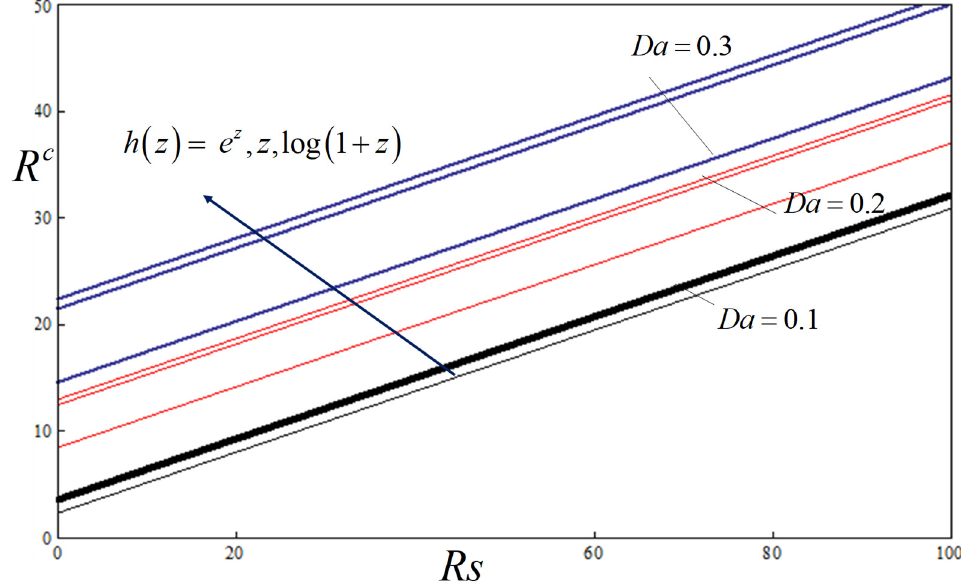
Figure 12. Plot of R c versus Rs for three cases of negative gravity fluctuation for various values of Da with Le = 0.5, Rs = 10, Da = 0.1, ξ = 0.5 and δ = 0.5.